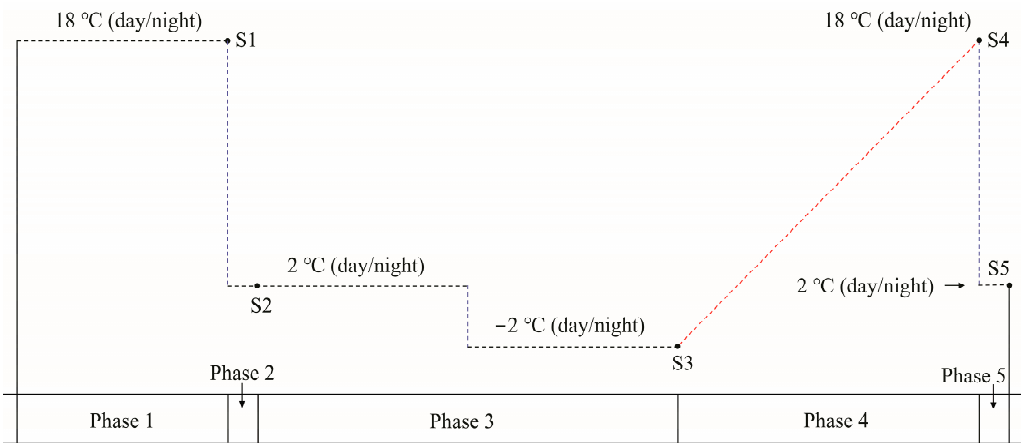
Figure 1. Phases 1 to 5 of the experimental treatment. Phase 1 consisted of 1 week of adaptive growth at 18 °C (day/night). During phase 2, the temperature was decreased to 2 °C (day/night) for one day. at 18 ◦ C (day / night). During phase 2, the temperature was decreased to 2 ◦ C (day / night) for one day. During phase 3, cold acclimation was carried out for 1 week at 2 °C (day/night), and the temperature During phase 3, cold acclimation was carried out for 1 week at 2 ◦ C (day / night), and the temperature was then decreased to − 2 °C (day/night) for an additional week of cold hardening. Phase 4 involved was then decreased to − 2 ◦ C (day / night) for an additional week of cold hardening. Phase 4 involved increasing the temperature to 18 °C (day/night) at the rate of 2 °C/day to simulate deacclimation. In increasing the temperature to 18 ◦ C (day / night) at the rate of 2 ◦ C / day to simulate deacclimation. phase 5, the temperature was decreased to 2 °C (day/night) for one day. A 12 h photoperiod and a In phase 5, the temperature was decreased to 2 ◦ C (day / night) for one day. A 12 h photoperiod and a photosynthetic photon flux density of approximately 100–150 μ mol m − 2 s − 1 were used during all five photosynthetic photon flux density of approximately 100–150 µ mol m − 2 s − 1 were used during all five phases. S1 to S5 indicate sampling points at the end of each treatment phase. phases. S1 to S5 indicate sampling points at the end of each treatment